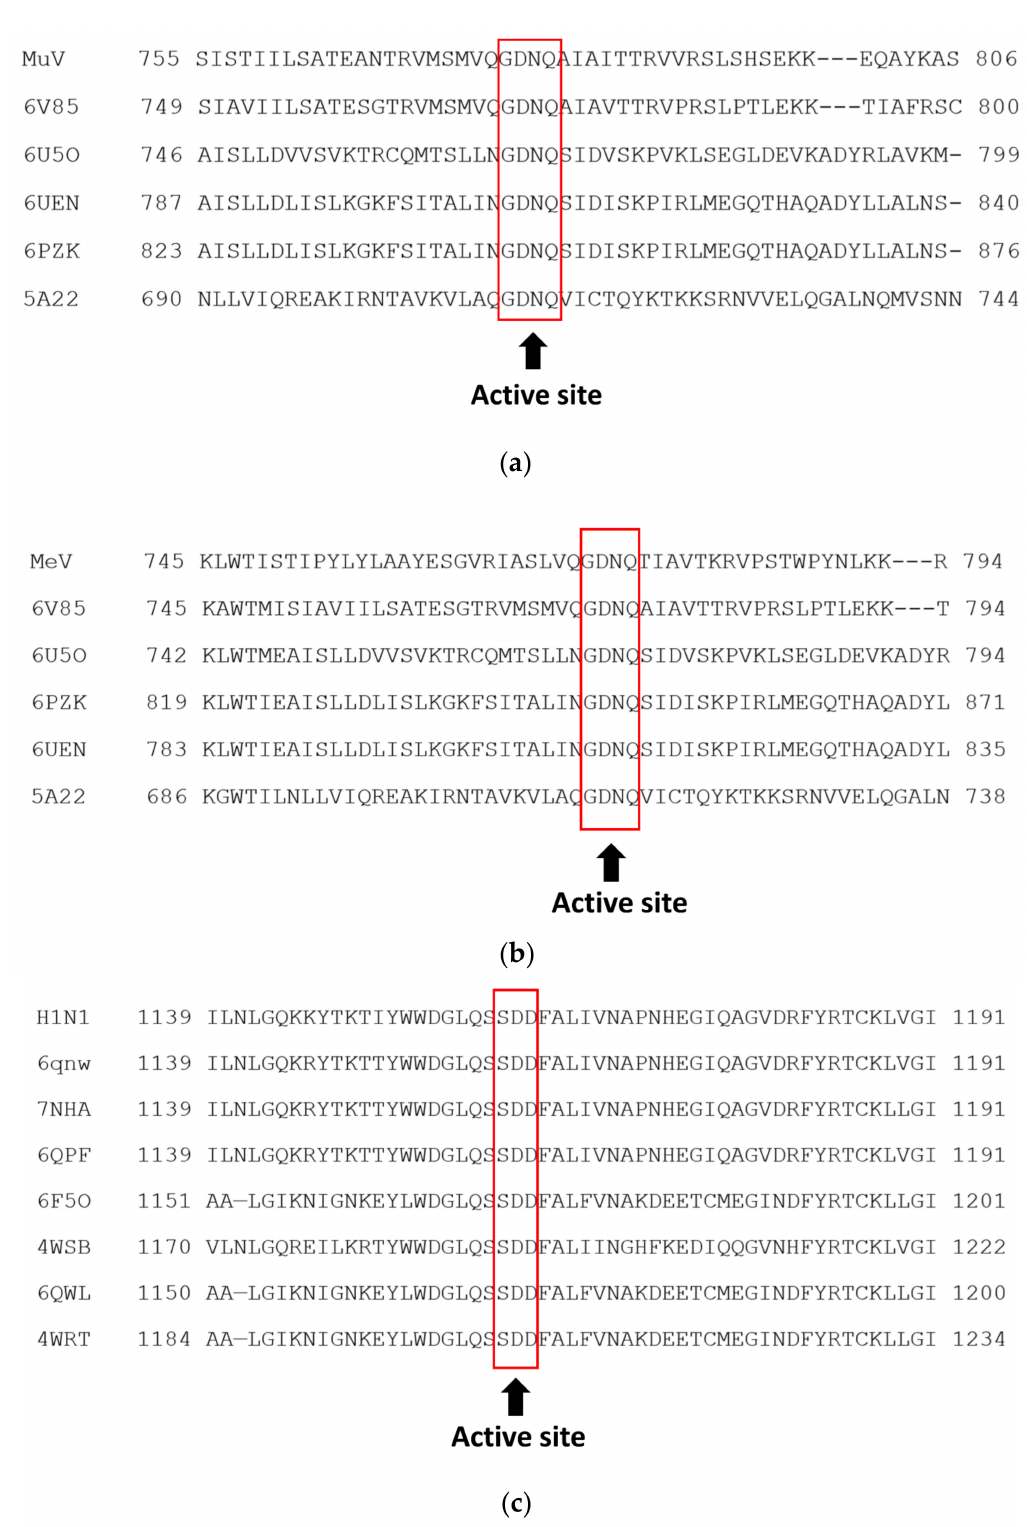
Figure 1. Diagram illustrating the multiple sequence alignment of RNA-dependent RNA polymerase (RdRp) amino acid sequences of ( a ) mumps virus (MuV), ( b ) measles virus (MeV), and ( c ) influenza H1N1 and other templates selected. The boxes indicate the active sites in